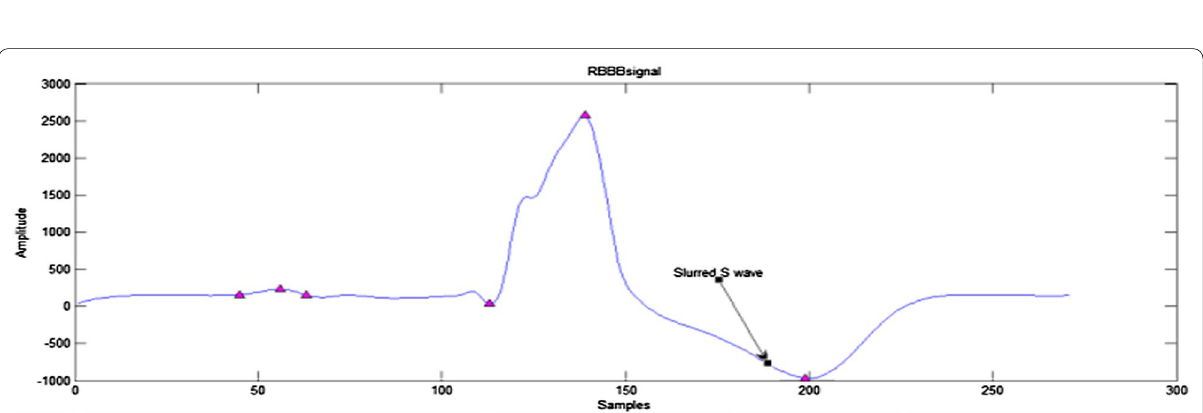
Fig. 16 Averaged signal of RBBB of record 212 and detected fiducials: The figure shows the folded signal of RBBB arrhythmia based on the period-dependent gate which gives the averaged information about the